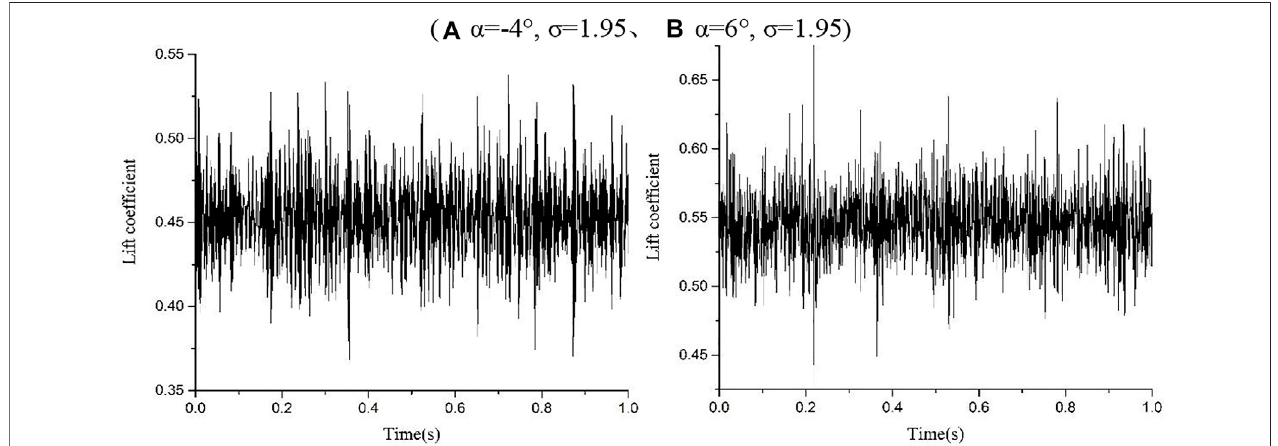
FIGURE 10 | Original lift signals at cloud cavitation conditions.